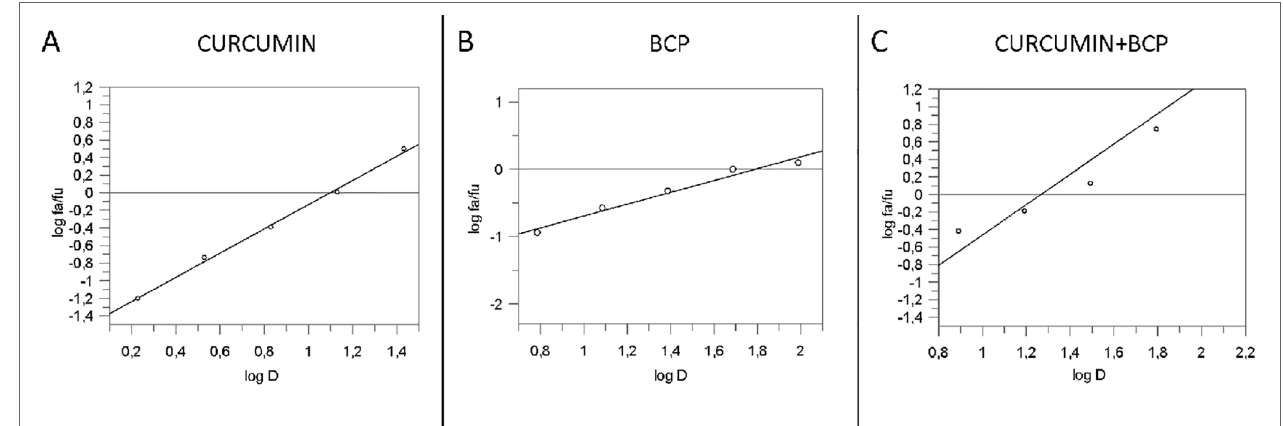
FIgURE 5 | Median effect plot for curcumin (panel A ), BCP (panel B ) and curcumin-BCP in combination (molar ratio, 1:3.6) (panel C ). D is the dose, f a and f u the affected and the unaffected fraction, respectively by the dose D.